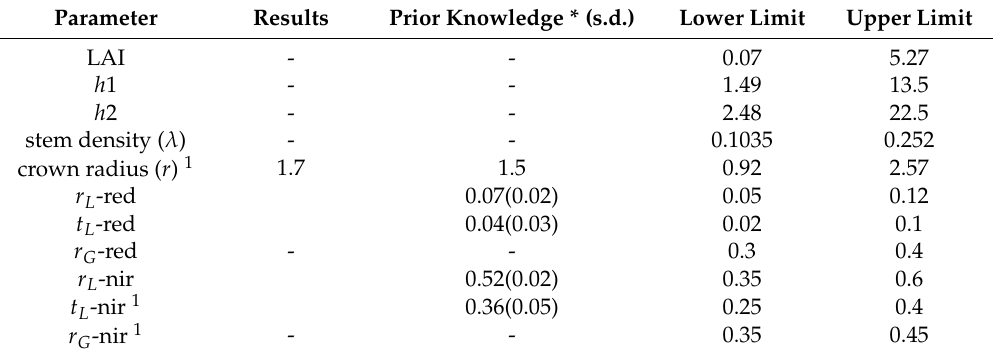
Table 2. Prior knowledge of input parameters and corresponding value ranges used in sensitivity analysis. Parameter Results Prior Knowledge * (s.d.) Lower Limit Upper Limit